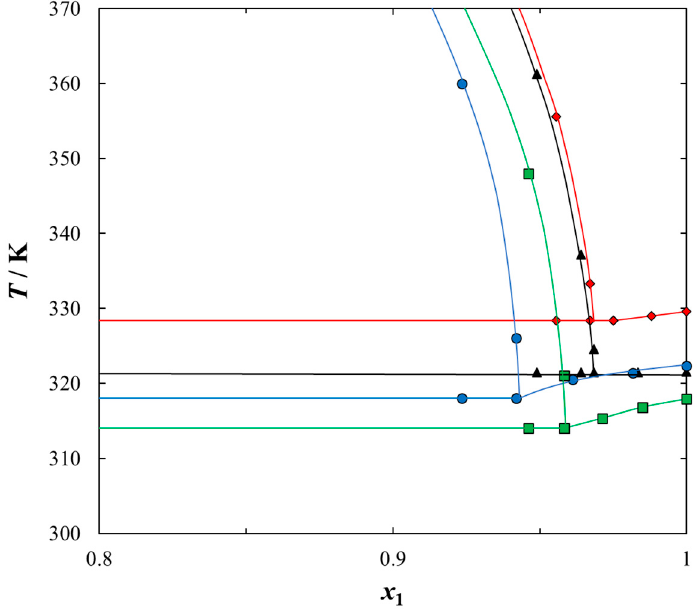
Figure 5. Experimental (solid + liquid), SLE and (liquid + liquid), LLE phase equilibrium data for {IL (1) + heptane (2)} binary system: ♦ , [BQuin][NTf 2 ]; ▲ , [BiQuin][NTf 2 ]; ■ , [HQuin] [NTf 2 ]; ● , [OQuin][NTf 2 ]. Solid line is the guide to the eye.